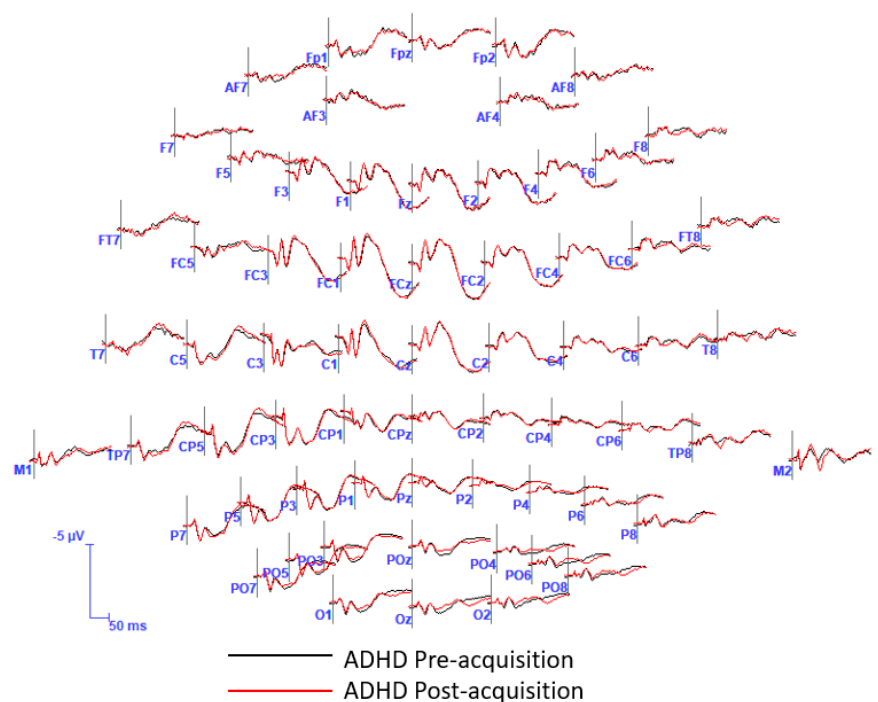
Figure A1. Depiction of the FMT pre (baseline) and post grand-average ERP waveforms for the ADHD group. This illustrates the distribution of scalp activity from all electrodes at the latency of—10 ms to 200 ms after median nerve stimulation.